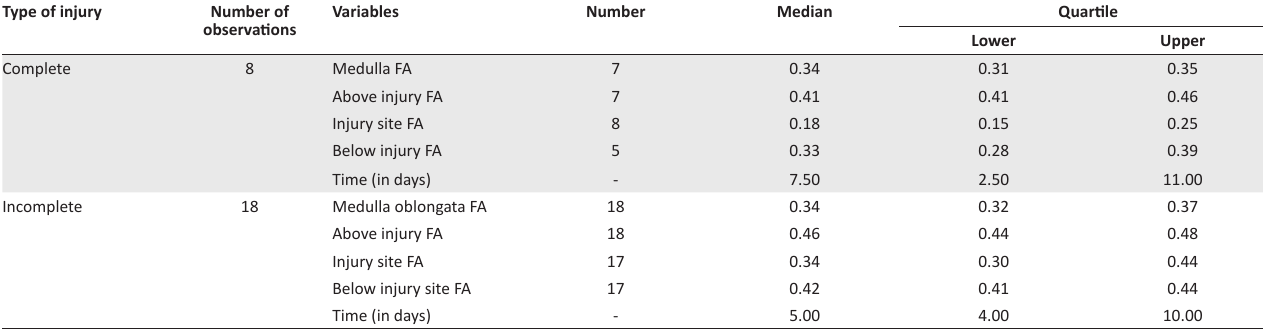
TABLE 3 : Breakdown of findings in patients with complete and incomplete neurological fallout.